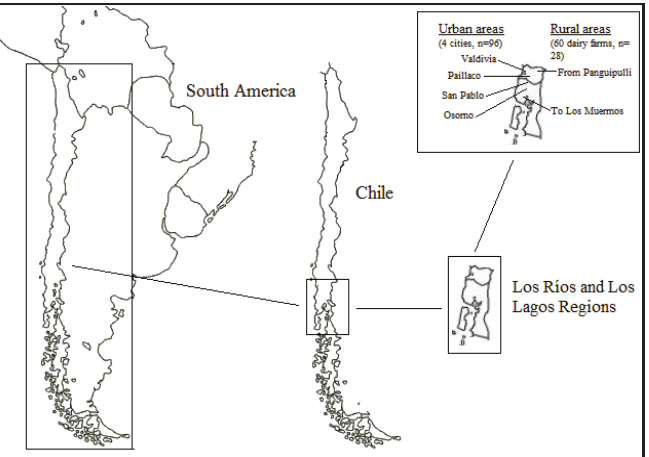
Figure 1. Approximate localization of the Los Rios and the Los Lagos regions in Chile and South America and the study